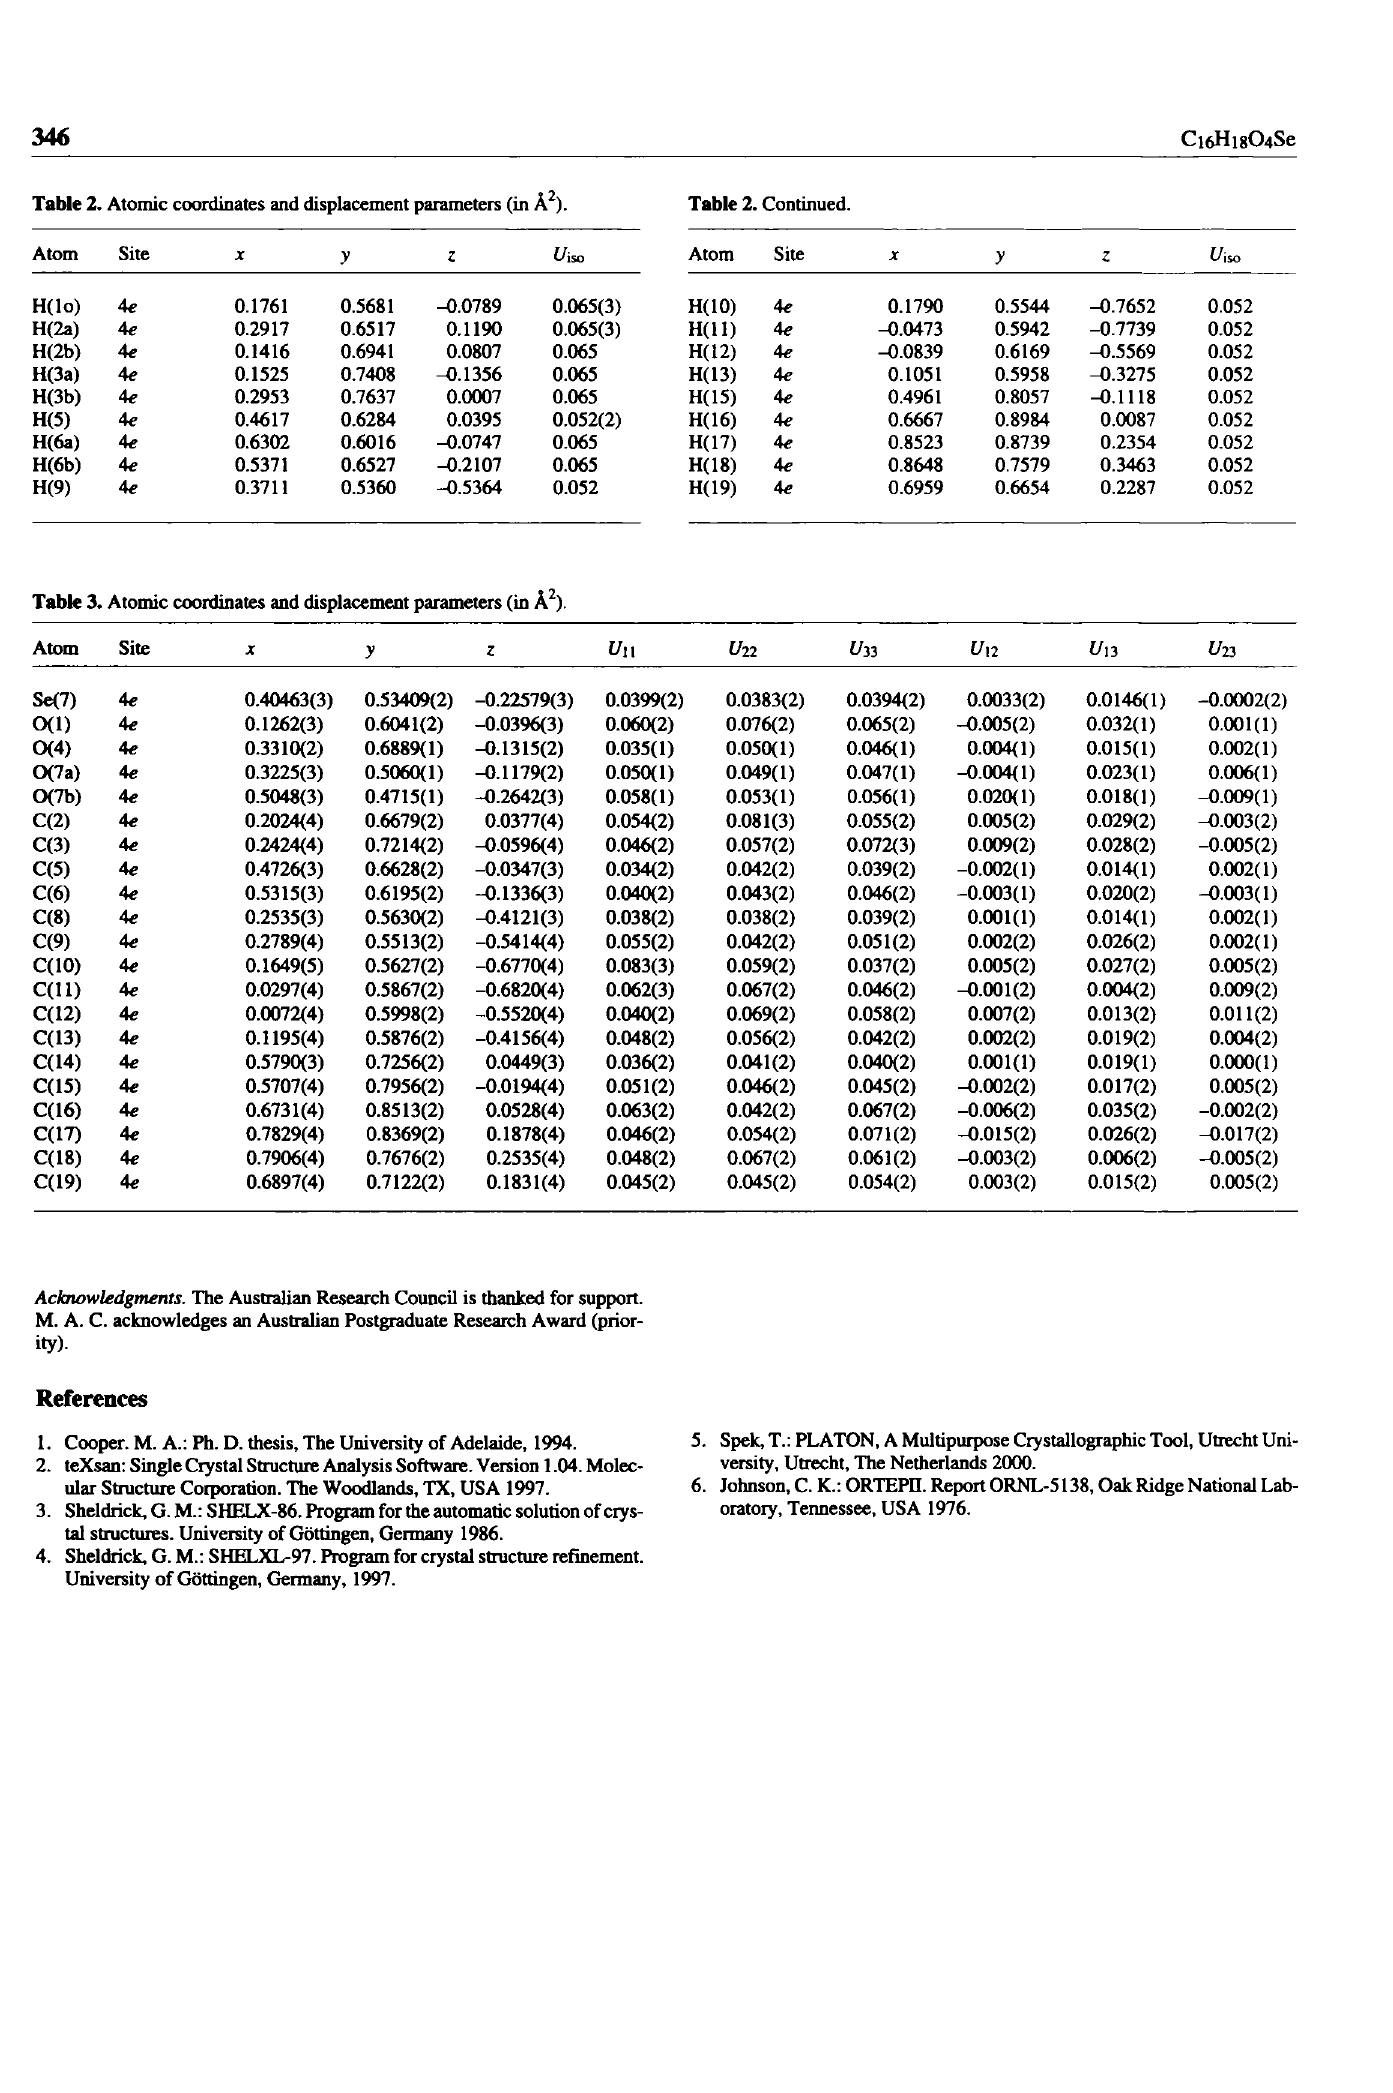
Table 3. Atomic coordinates and displacement parameters (in À 2